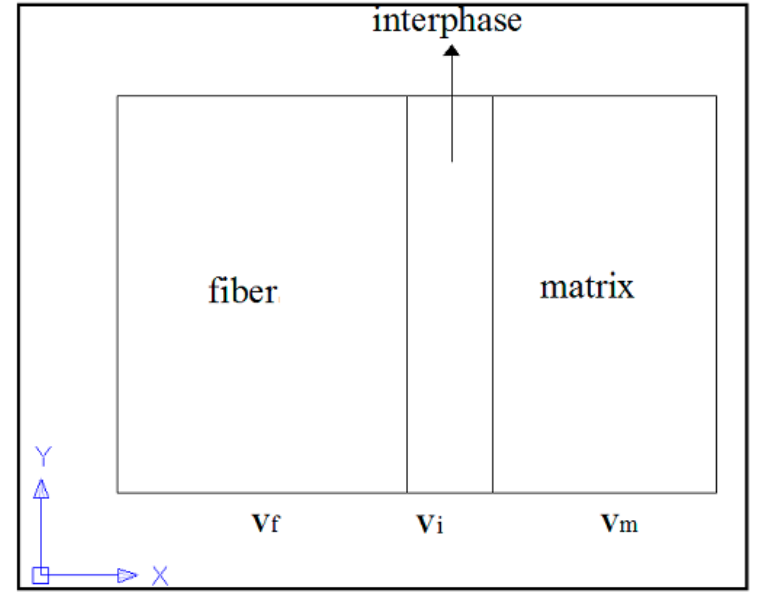
Figure 4. Simplified model of the composite